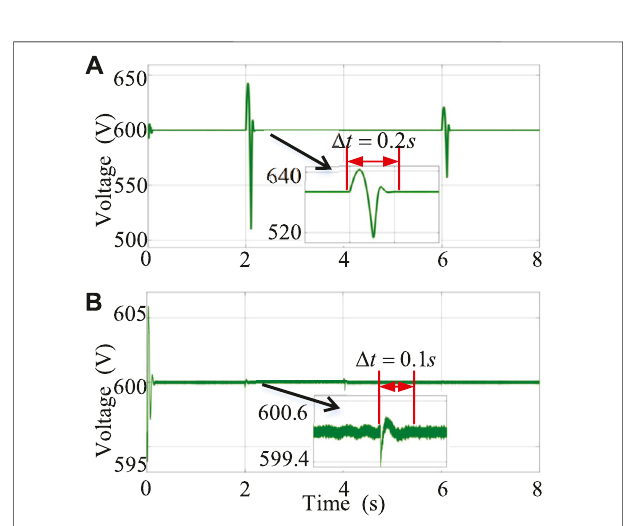
FIGURE20|(A) v dc ofthe system without SCincase 2; (B) v dc ofHESS in case 2.